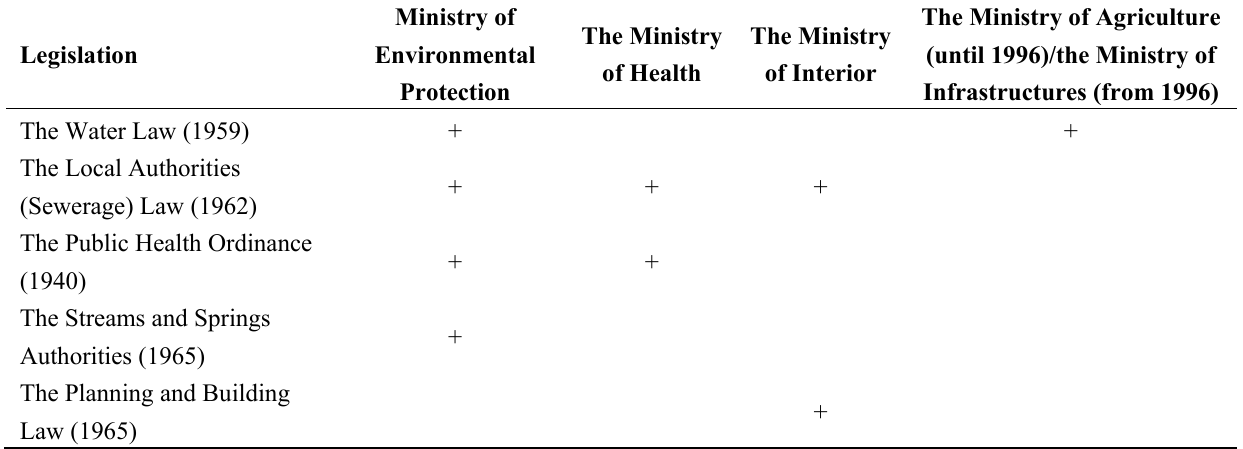
Table 2. Relevant legislation for water pollution control and the actors entrusted with the ministerial responsibilities over them,